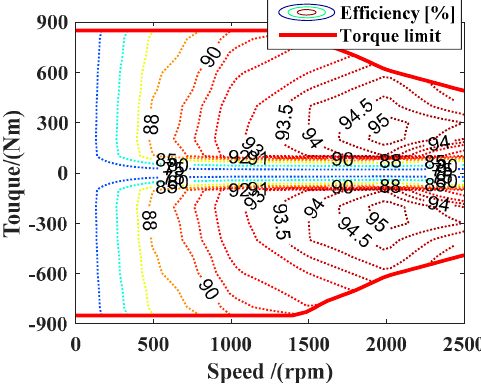
Figure 6. Efficiency map of the motor. Figure 6. E ffi ciency map of the motor.